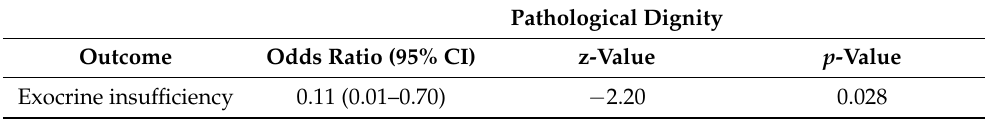
Table A8. Effect of pathological dignity in selected